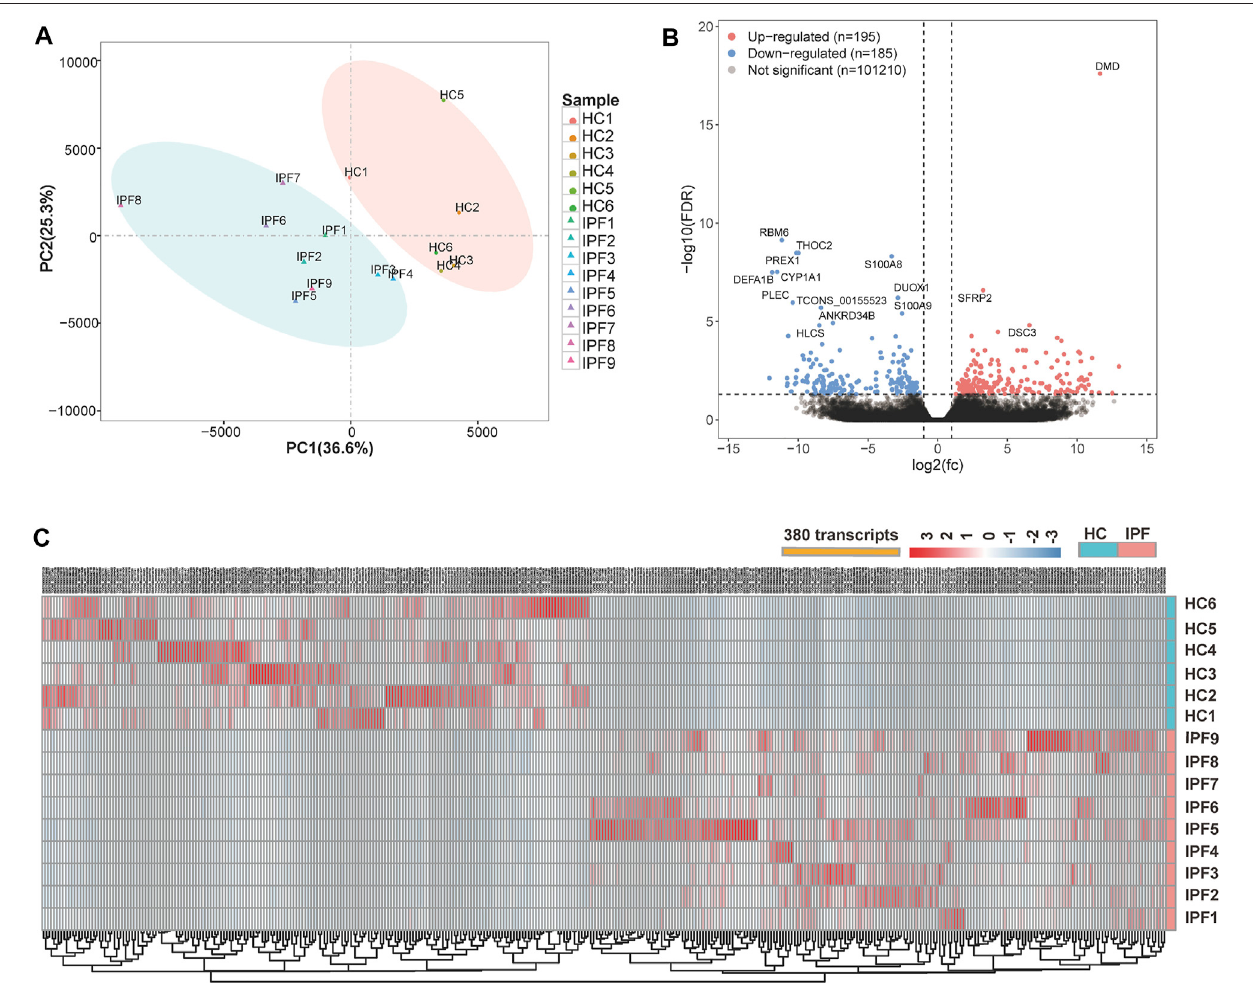
FIGURE2| Overviewofthedifferentialexpression oftranscripts betweenlungtissuesamplesfrom patients withIPFandhealthycontrols. (A) Principalcomponent analysis of the mRNA-Seq for lung tissue samples shows a clear separation of the samples from HC and samples from patients with IPF. (B) Volcano plots depict signi fi cantly dysregulated gene changes of the IPF versus control at a false discovery rate (FDR) ＜ 0.05 and |log2FC| > 1. Downregulated genes are shown in blue, and upregulatedgenesshown inred.DMD isatranscriptwiththe lowest p -value. (C) Heatmap shows theoverall distribution ofeach differentially expressed transcript in all samples from IPF and HC. Abbreviations: FC, fold change; IPF1 – IPF7, the lung samples of IPF with early stage from SLB; IPF8 – IPF9, the lung samples of IPF with transplant stage from lung